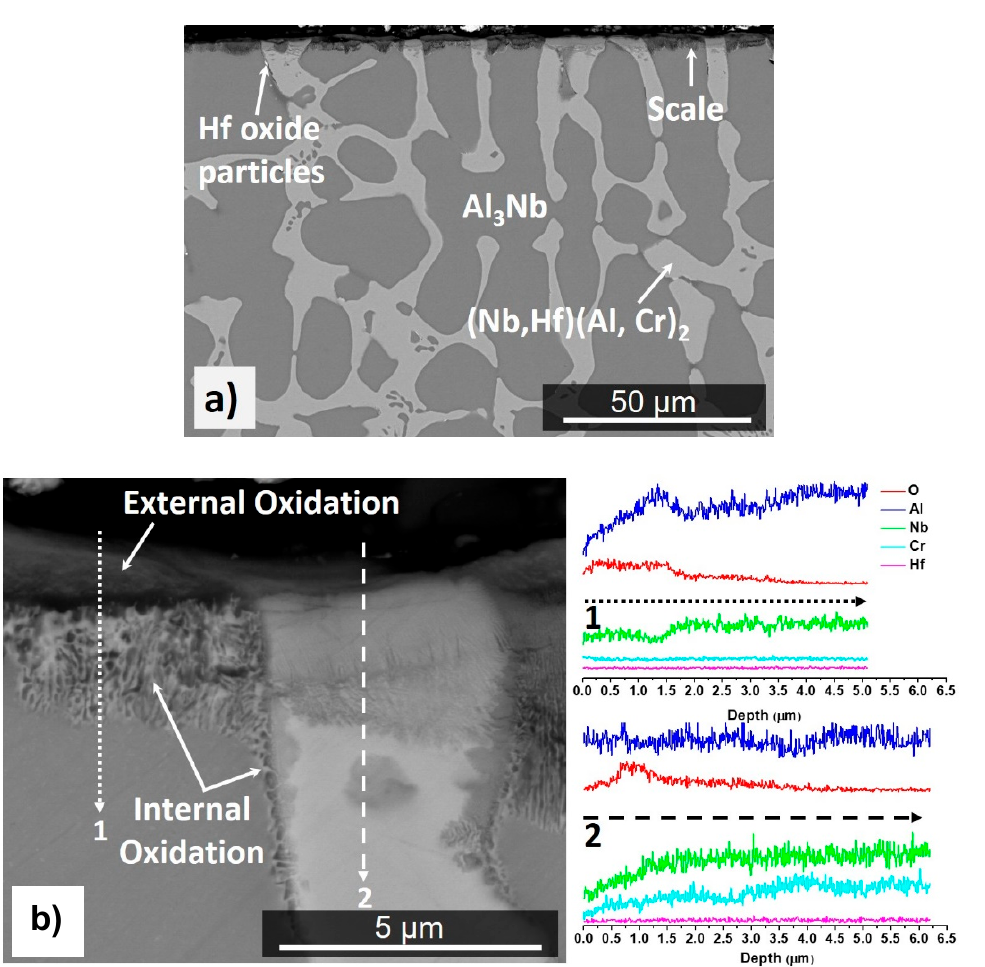
Figure 8. BSE images of cross-sections of the alloy OHC3 after isothermal oxidation in air at 800 °C for 100 h (a) X1600, (b) elemental line scans (BSE image X24000).